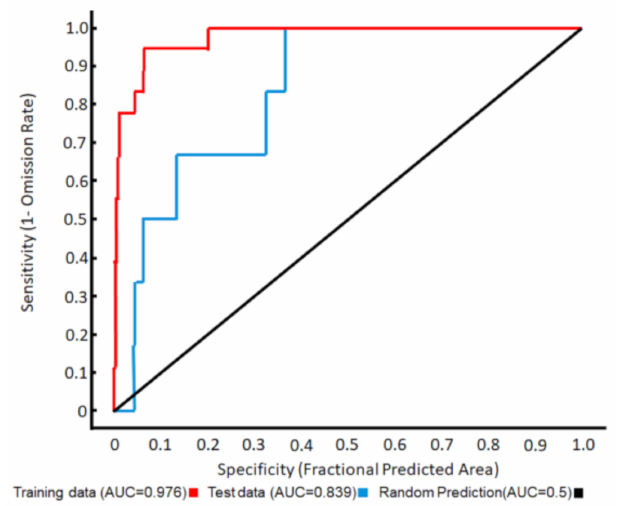
Figure 5. ROC curve for the MAXENT modelling of the potential distribution of Anoxia orientalis in Sicily.